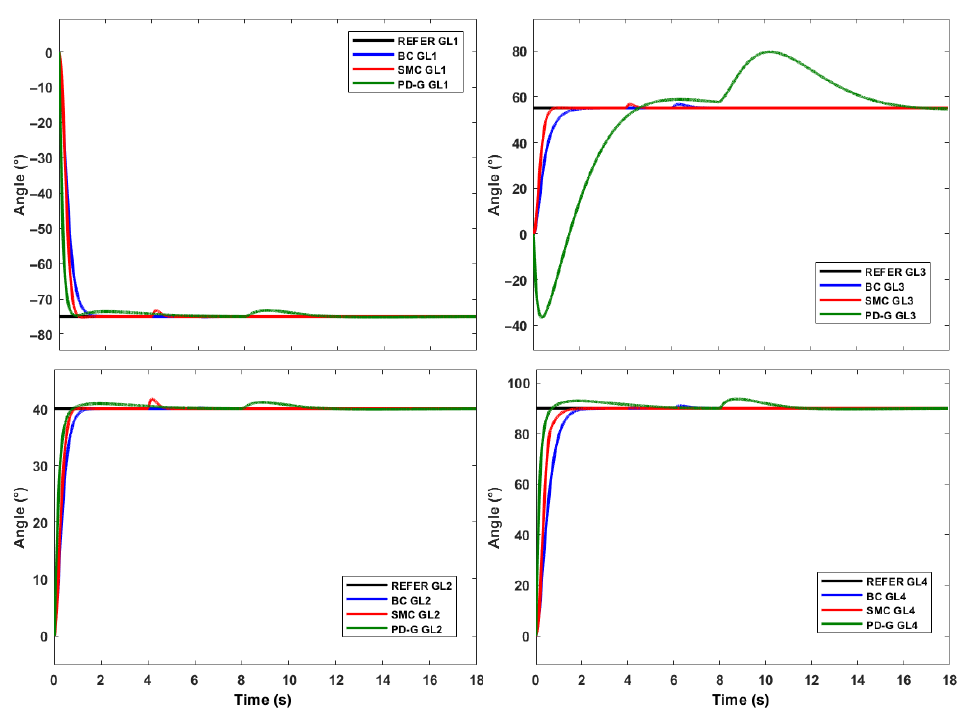
Figure 13. Positions of 4 manipulators applying a torque